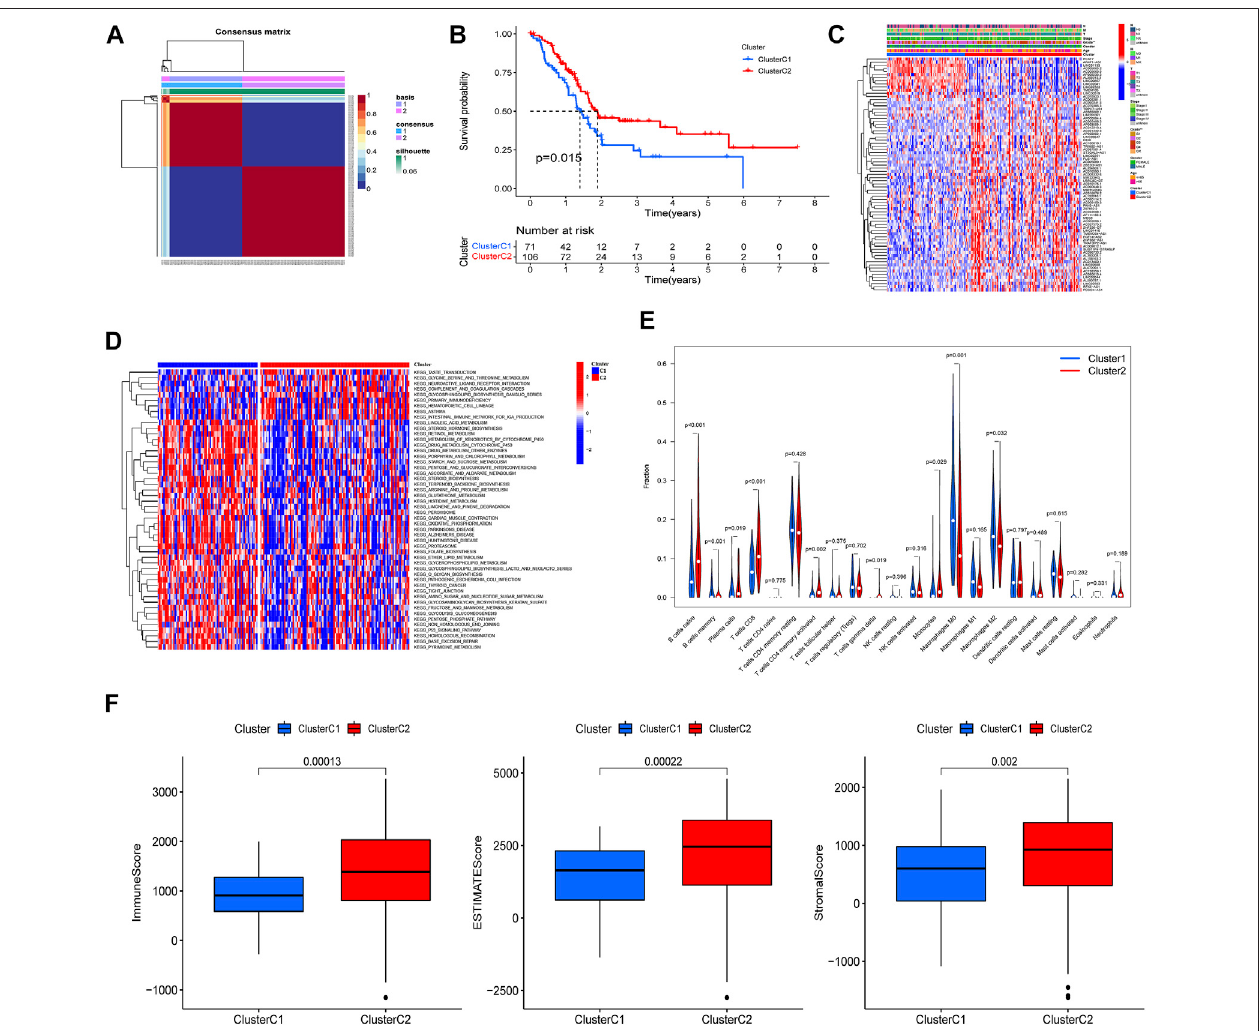
FIGURE 4 | PAAD cluster analysis based on prognostic PRlncRNAs. (A) A total of 177 PAAD patients were classi fi ed into two clusters through the unsupervised cluster analysis (Cluster C1: 71, Cluster C2: 106). (B) K-M survival curve showed that cluster C2 had a poorer prognosis compared to cluster C1 ( p = 0.015). (C) The relationshipbetweenclinicopathologicalfeaturesand clusterswasshownintheheatmap(** p < 0.01). (D) Genesetvariationanalysis(GSVA)revealeddifferentbiological pathways between the two clusters. (E) The violin plot displayed the differences in immune cell in fi ltration between two clusters according to the CIBERSORT algorithm. (F) Immune,Estimate,andStromalscoreswerecalculatedintwoclustersthroughtheESTIMATEalgorithm,andallthreeachievedhigherscoresinclusterC2.